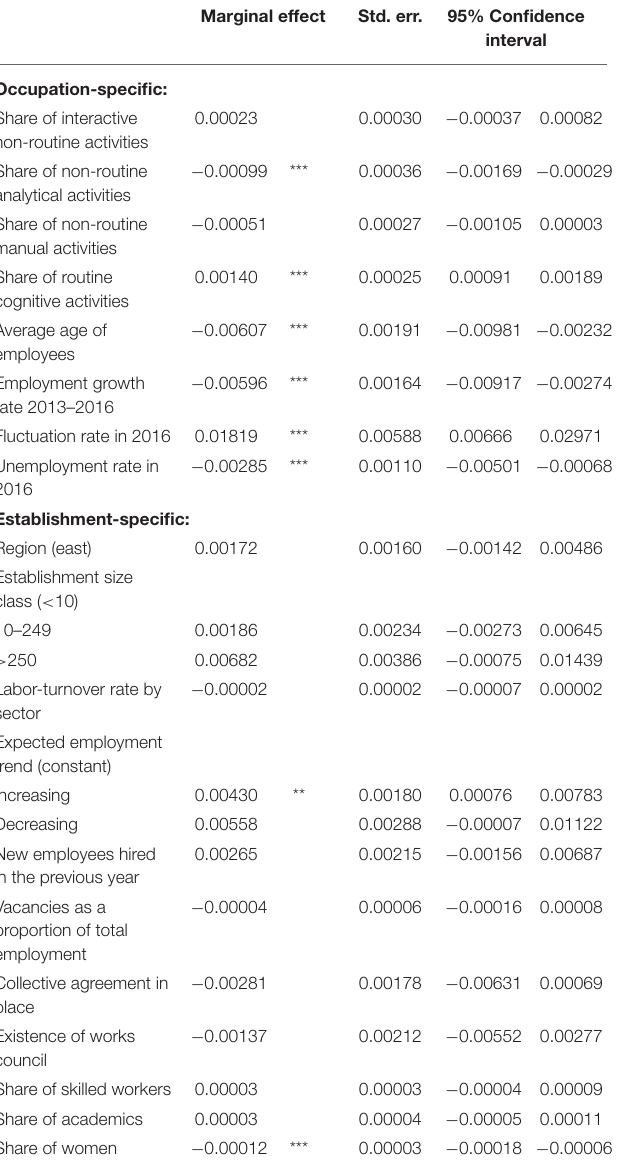
TABLE 9 | Marginal effects: increasing requirements regarding short term flexibility in working time. Marginal effect